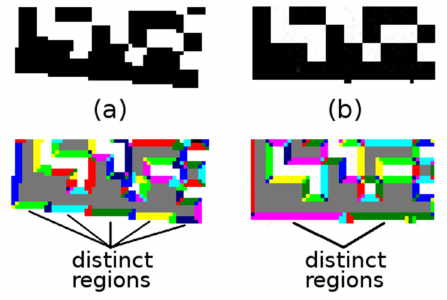
Figure 5. ( a ) “sharp stairs”; ( b ) “bumpy